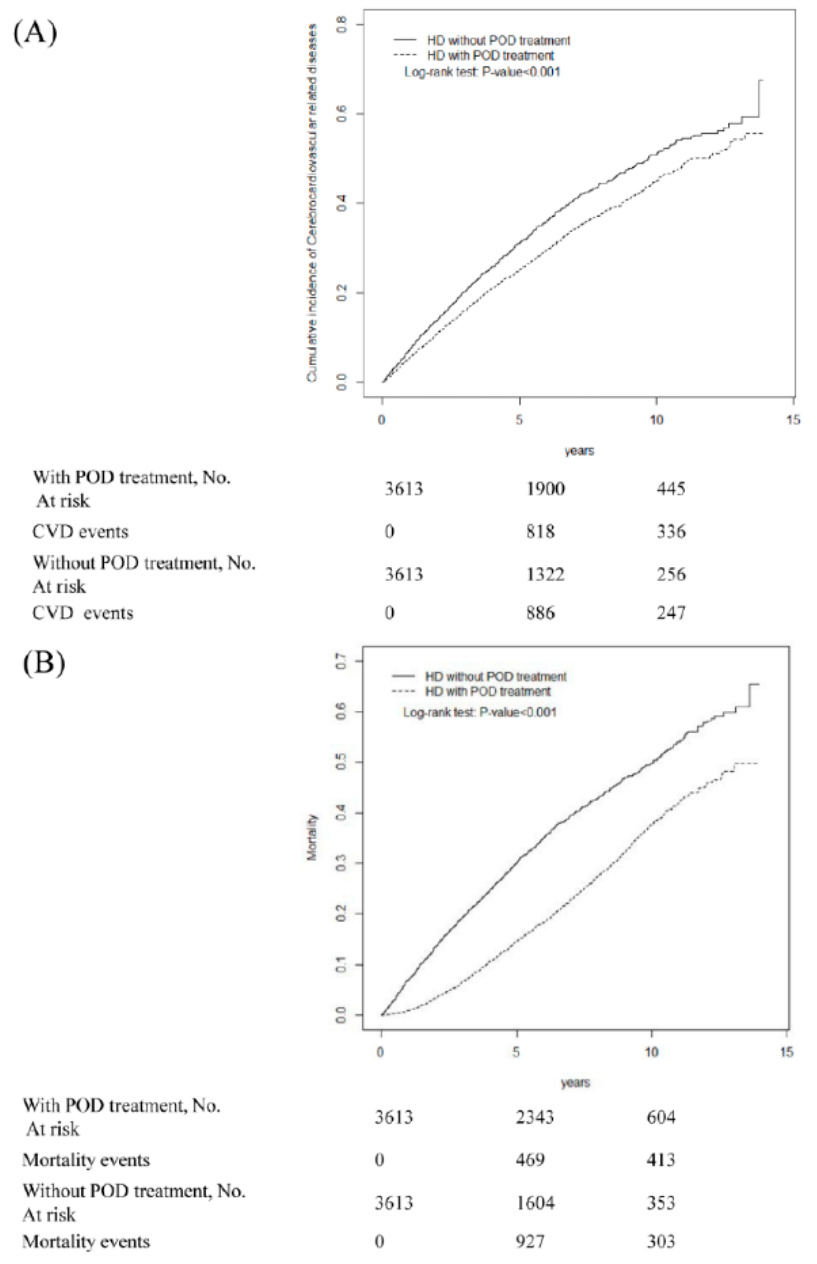
Figure 3. Cumulative incidence of cardiovascular diseases ( A ); and mortality ( B ) for dialysis patients with treatment (dashed line) or controls (solid line). HD: hemodialysis; POD: periodontal disease; CVD: cardiovascular disease.